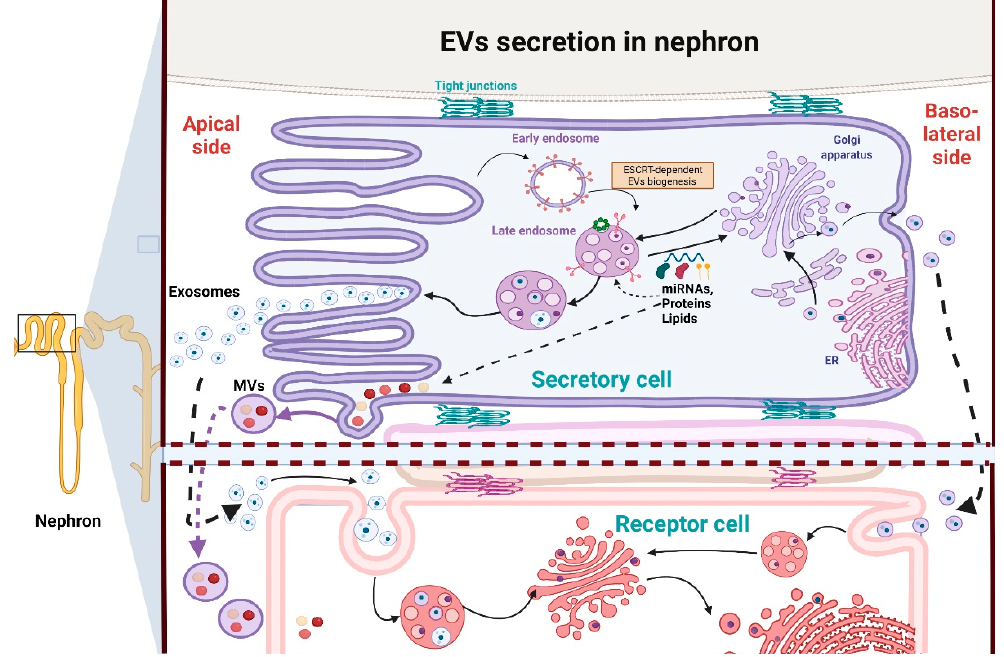
Figure 1. Extracellular vesicles’ (EVs) secretion in nephron segments. In the nephrons, the exo- somes and microvesicles (MVs) are strongly affected by the polarity of the cells, especially in a tubular section such as the proximal tubule. Although both the apical and basolateral EVs use components of endosomal sorting complexes required for transport (ESCRT) machinery, the final composition of lipids, proteins, and genetic material is different between them. For example, apical EVs are more enriched in CD24 and lipids such as cardiolipin, ceramide, and phospholipids than basolateral counterparts. Additionally, the apical side releases 3-fold more exosomes under healthy physiological conditions than the basolateral side. EVs allow communication between distant nephron segments since the EVs released from upper nephron segments can be taken in by the cells in lower segments. Image created with Biorender.